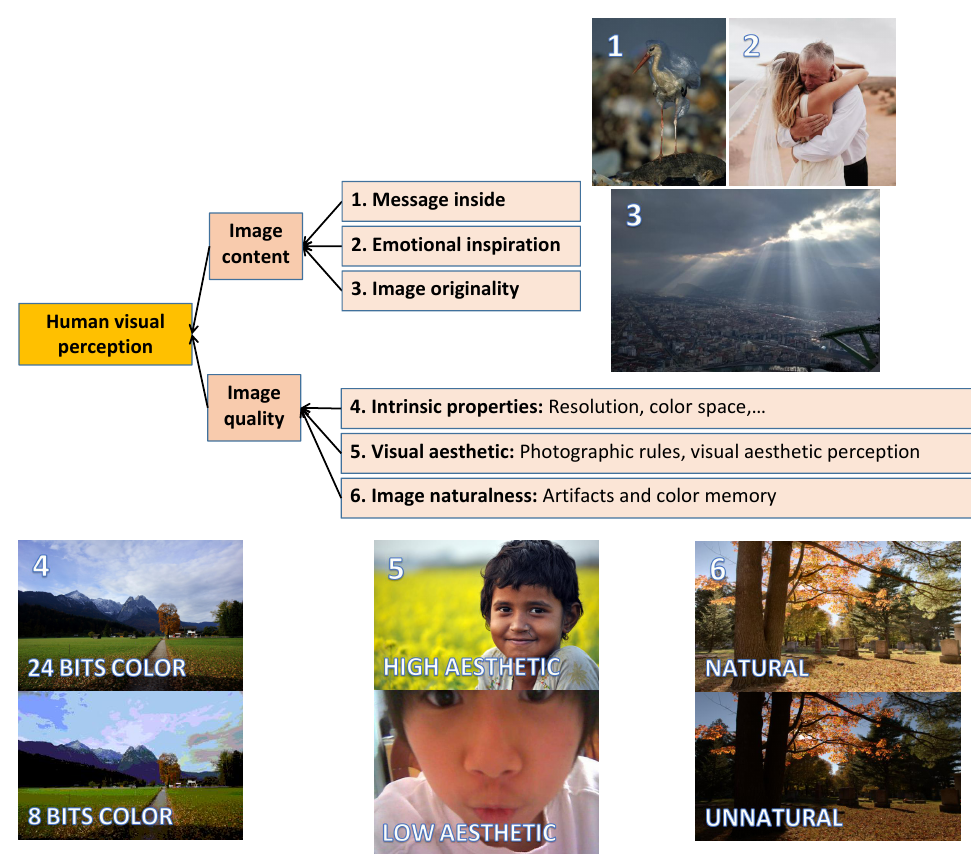
Figure 1. Overview of image aspects having an influence on human visual